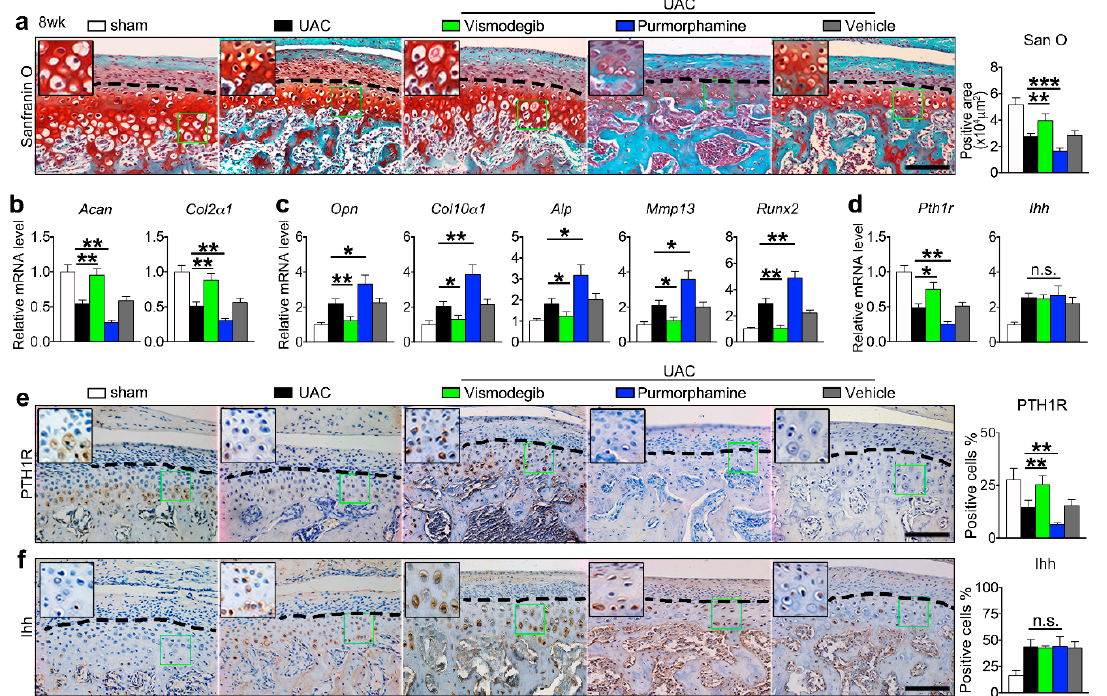
Figure 5. The effect of drug-modified Ihh signaling on UAC stimulated deep zone chondrocytes terminal differentiation in TMJ cartilage of rats. Vismodegib or purmorphamine (1 μ M) was injected in TMJ region from 4 to 8 weeks after UAC treatment. ( a ) Safranin O staining of TMJ and the quantitative data (right panel). ( b , c ) Comparison of mRNA expression of cartilage matrix and terminal differentiation markers. ( d ) The mRNA expression of Pth1r and Ihh . ( e ) Immunohistochemical staining for PTH1R and its quantification of percentage of the positive cells (right panel). ( f ) Immunohistochemical staining of Ihh and its quantification of percentage of the positive cells (right panel). The green box regions in the images were magnified at the top left corner. Black dotted lines distinguish the superficial and deep zone chondrocyte. SZ , superficial zone. DZ , deep zone. SB , subchondral bone. Magnification, 200×. Scale bar, 100 μ m. IHC staining: n = 6. qPCR analysis: n = 3. Results are represented as the mean ± SD. * p < 0.05, ** p < 0.01, *** p < 0.001.